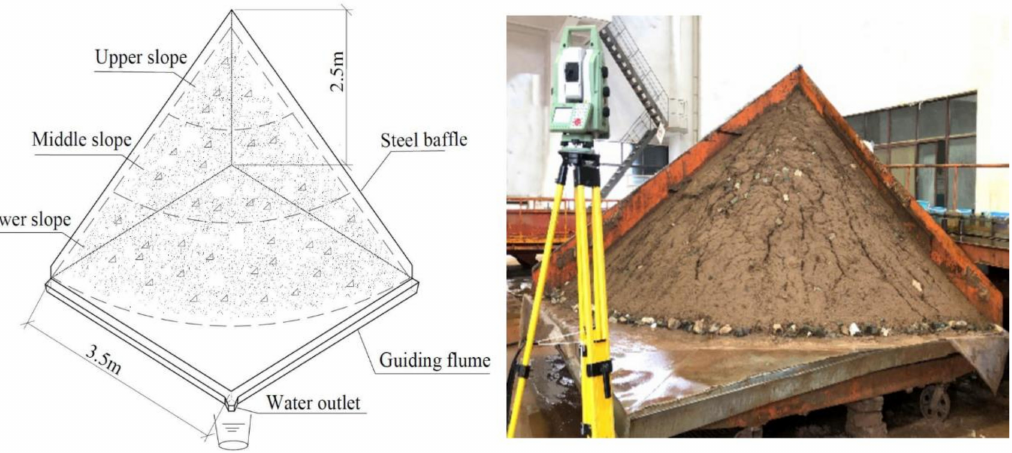
Figure 1. Experimental